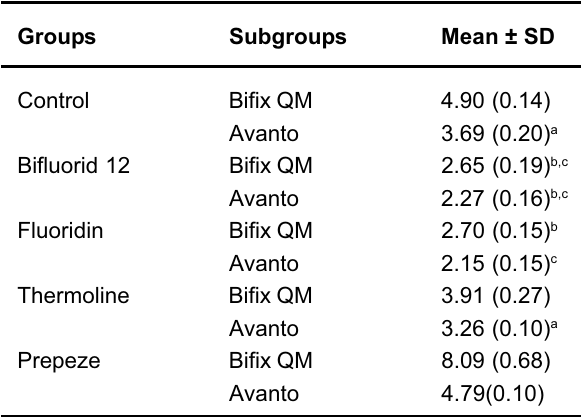
Same letters indicate statistically significant difference